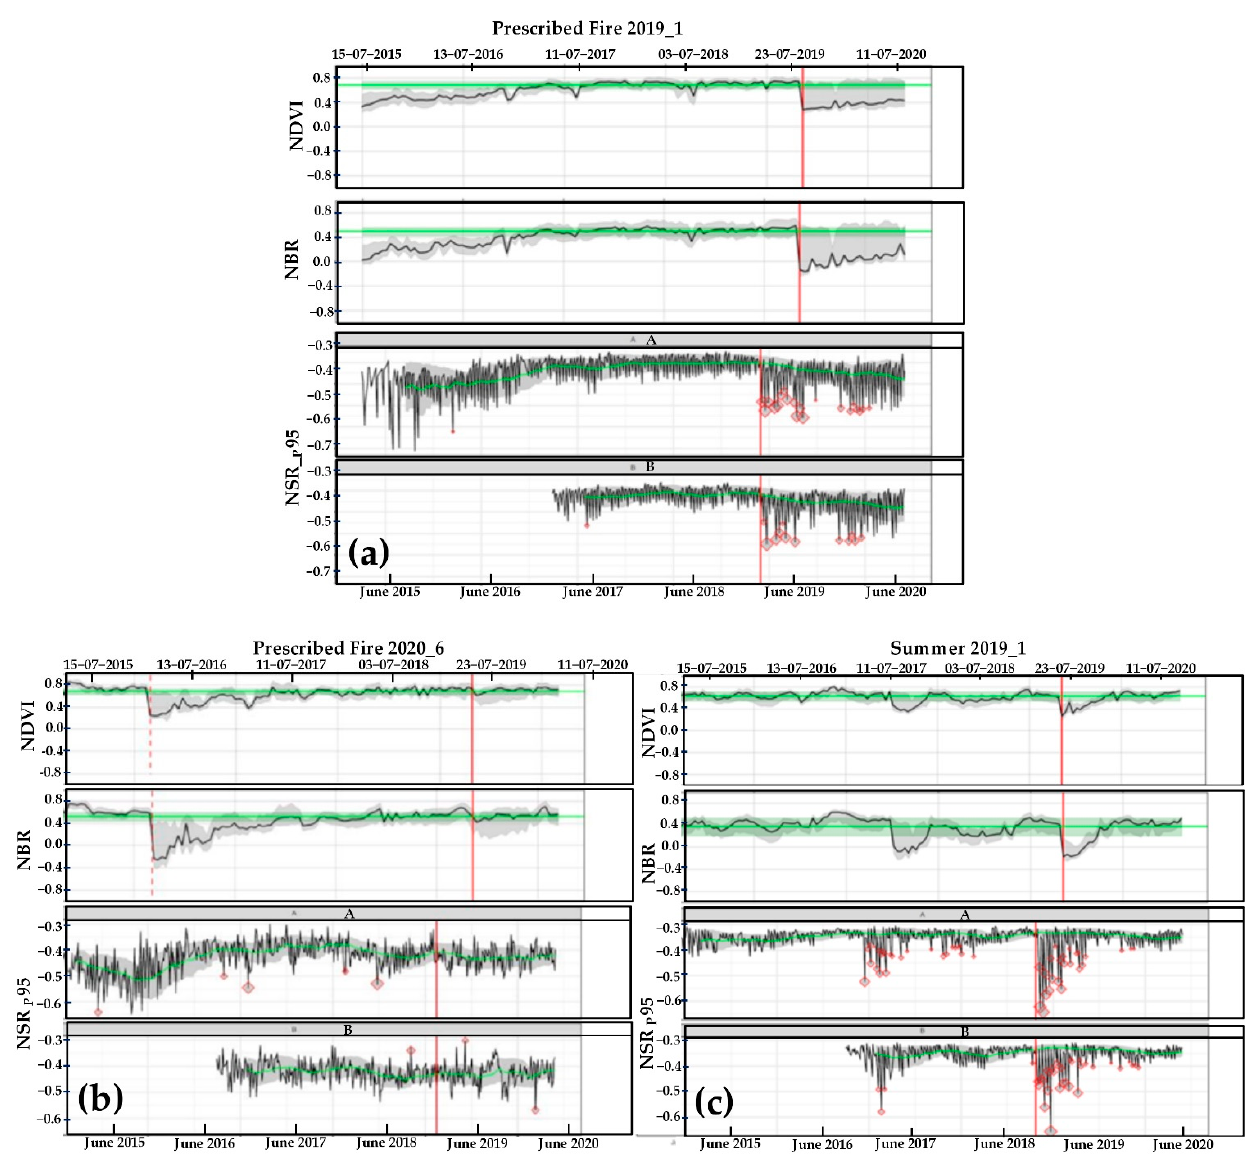
Figure 8. SAR and spectral indices comparison; ( a ) Top image is an example of SAR NSR_p_95 workings perfectly following the fire event, ( b ) Left image shows SAR identifying fires inappropriately, ( c ) Right image shows SAR and spectral indices dropping their values.